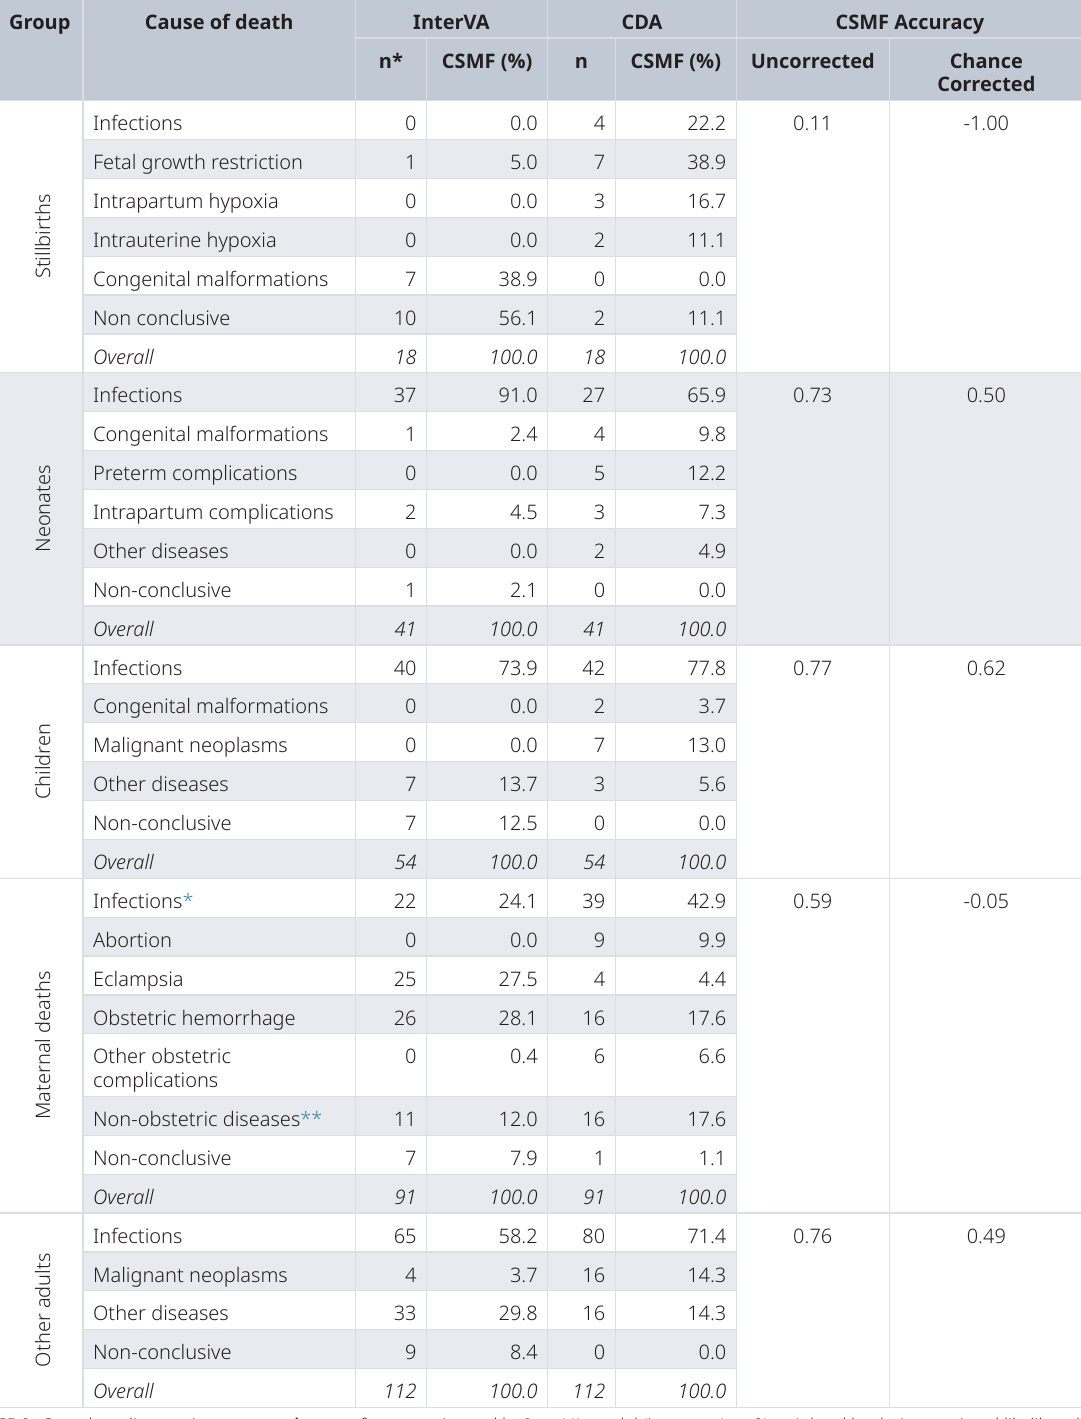
Table 4. Cause-Specific Mortality Fractions and associated measures of validation of the InterVA (Interpreting Verbal Autopsy) model compared with the complete diagnostic autopsy (CDA) at the population level. Group